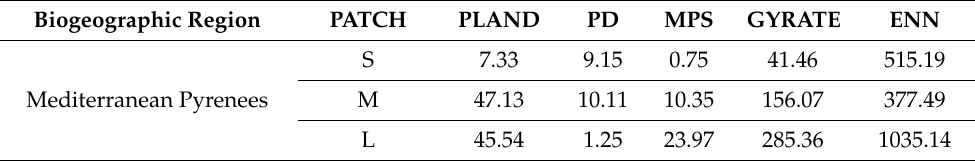
Table 3. Configuration analysis for Mediterranean mountain regions. S (patches with an average area of 1 ha), size M (patches with an average area of 5 ha) and size L (patches with an area average of 50 ha).